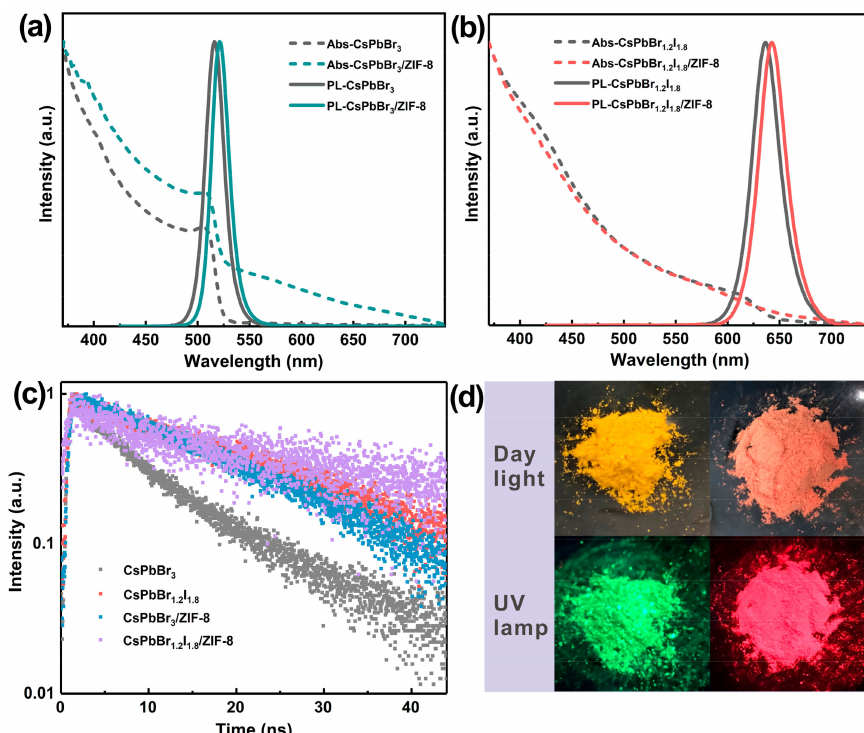
Figure 5. ( a ) UV-vis absorption (dashed line) and photoluminescence (PL) (solid line) spectra of CsPbBr 3 and CsPbBr 3 / ZIF-8 dispersed in hexane; ( b ) UV-vis absorption (dashed line) and PL (solid line) spectra of CsPbBr 1.2 I 1.8 and CsPbBr 1.2 I 1.8 / ZIF-8 dispersed in hexane; ( c ) time-resolved PL decay curves of CsPbBr 3 , CsPbBr 1.2 I 1.8 , CsPbBr 3 / ZIF-8, and CsPbBr 1.2 I 1.8 / ZIF-8 powders; ( d ) photographs of CsPbBr 3 / ZIF-8 and CsPbBr 1.2 I 1.8 / ZIF-8 powders under daylight and UV lamp (365